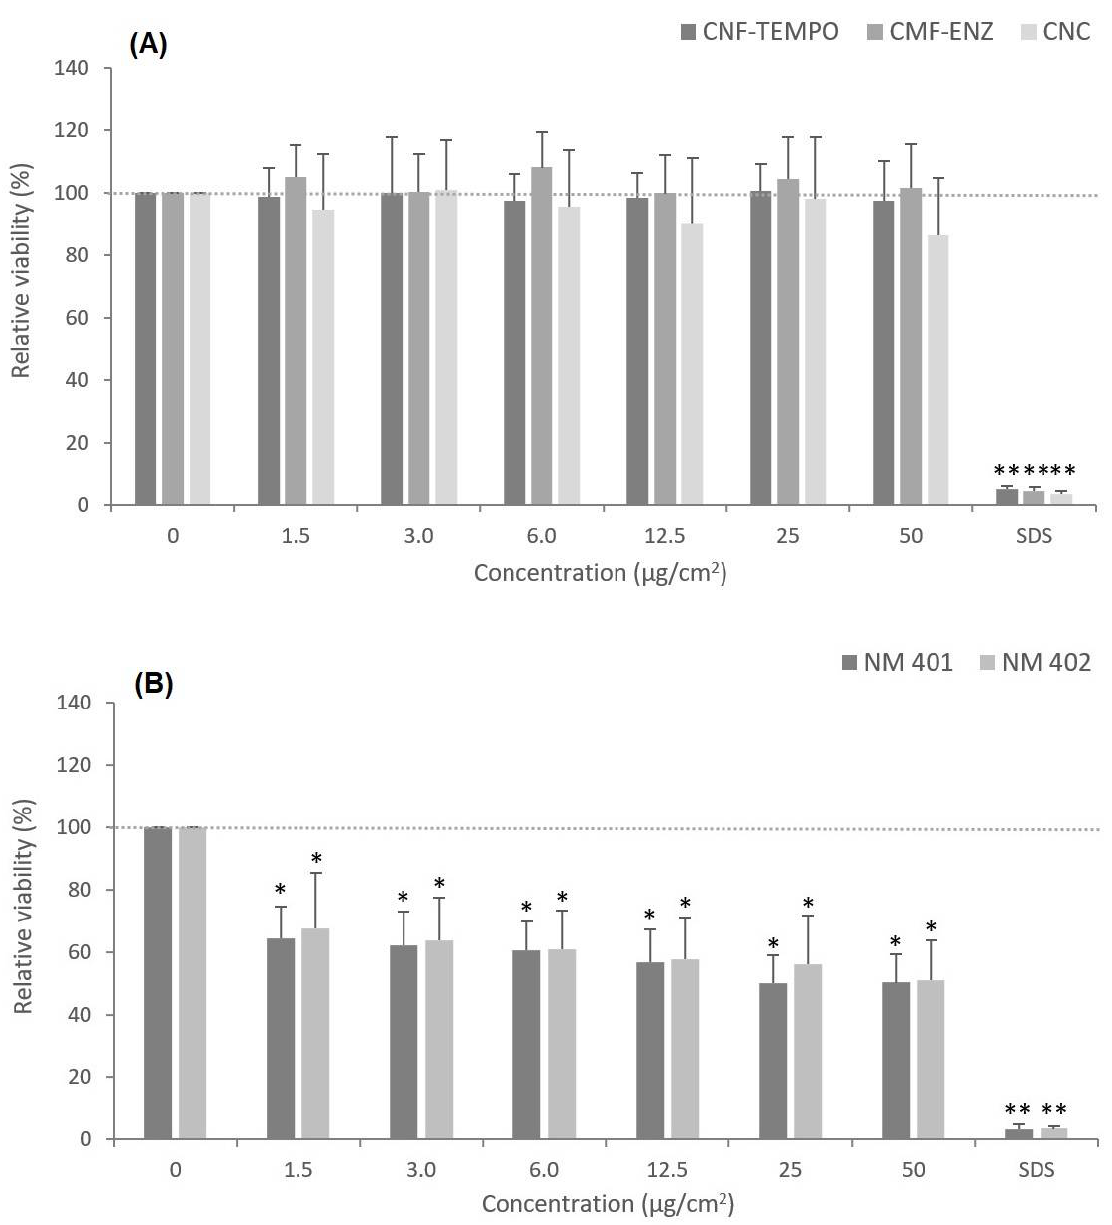
Figure 5. Effects of nanocellulose and MWCNT exposure at different concentrations on the viability of A549 cells assessed by the MTT assay, after 24 h exposure: ( A ) CNF-TEMPO, CMF-ENZ, and CNC; ( B ) NM-401, NM-402. The results are expressed as mean ± SD of three independent experiments, each carried out in triplicate. * p < 0.05, ** p < 0.01.